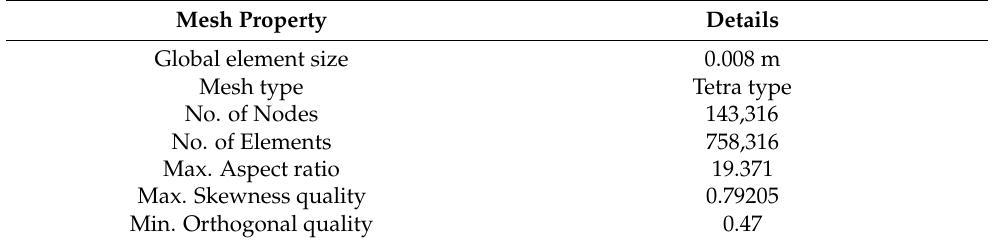
Figure 4. Computational mesh: ( a ) entire mesh; ( b ) rotating mesh; ( c ) zoom in on the rotating mesh. Table 2. Computational meshing properties.